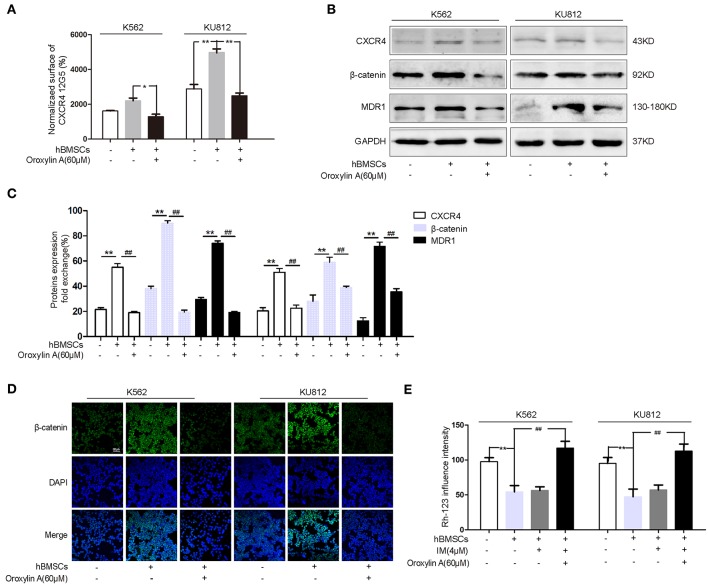
The CXCR4/β-catenin/ P-gp contributed to the reversal effects of Oroxylin A on IM-resistant CML cells. CML cells treated with Oroxylin A in co-culture model. (A) Flow cytometry analysis of 12G5 in K562 and KU812 cells. (B) Western blot analysis of expression of CXCR4, β-catenin, and P-gp in K562 and KU812 cells. (C) Analysis of proteins expression. (D) Immunofluorescence detection of the distribution of β-catenin in K562 and KU812 cells. (E) Intracellular Rh-123 fluorescence measurement in co-culture model cells treated with IM alone or combination with Oroxylin A. Data were shown as Means ± SD for three independent experiments (*p < 0.05, **p < 0.01, and ##p < 0.01).